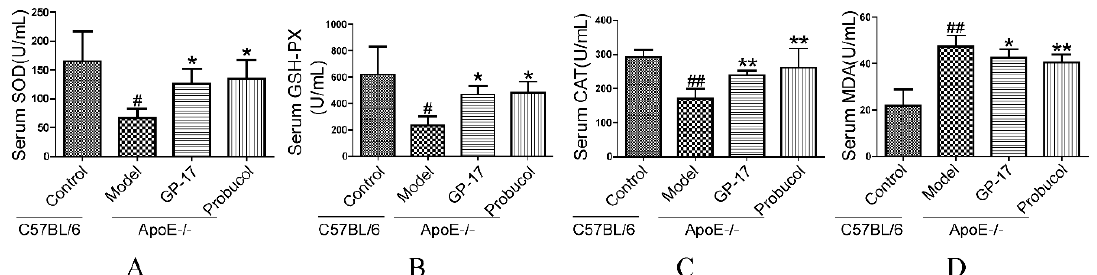
Figure 4. GP-17 increased the levels of SOD, GSH-Px and CAT and decreased MDA content in the serum. ( A ) Serum SOD level; ( B ) Serum GSH-Px level; ( C ) Serum CAT level; ( D ) Serum MDA level. The values are expressed as the mean ± S.E.M. ( n = 8 for each group). # p < 0.05; ## p < 0.01 vs. Control; * p < 0.05; ** p < 0.01 vs. Model.